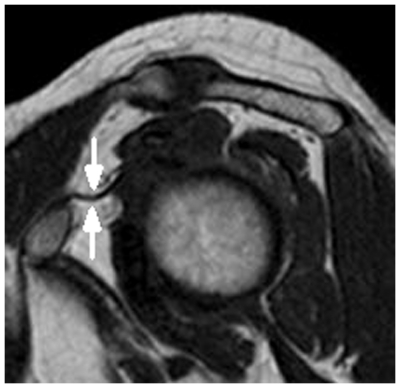
A 49-year-old male normal volunteer.Sagittal oblique, T1-weighted image (TR/TE = 550 ms/15 ms) demonstrates a normal CHL showing homogeneous , low signal intensity (arrows).